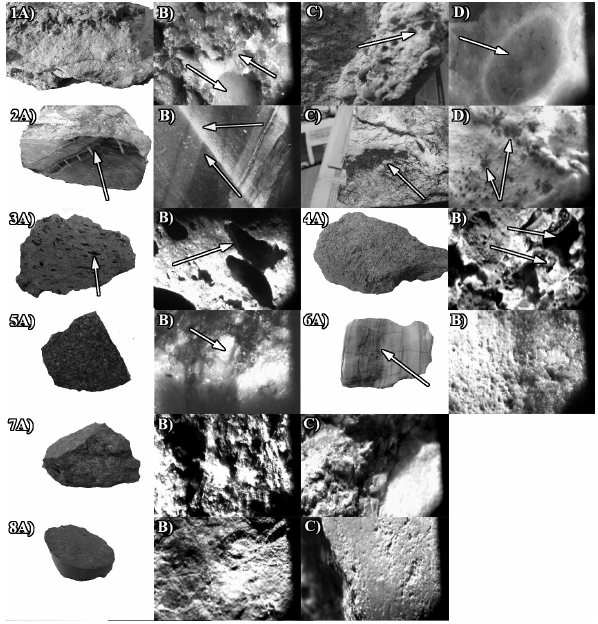
Figure 4. Images of the hand specimen of different Mars relevant type of rocks. Conglomerate and sandstone from Dunavarsány (Hungary) (1 A,B,C,D); contact metamorphic, siliceous limestone (2 A,B,C,D); amygdule basalt from Ság-hill (Hungary) (3 A,B); oxidised basalt lapilli (4 A,B); phanerocrystalline amphibolite andesite (5 A,B), chert and clay sandstone from Dunavarsány (6 A,B); hyialo- clastite breccia after chloritaziation (7 A,B,C); Bodai claystone ( 8 A,B,C); Jakabhegyi sandstone (9 A,B,C). Interesting small scale features are indicated by arrows (see the text for more